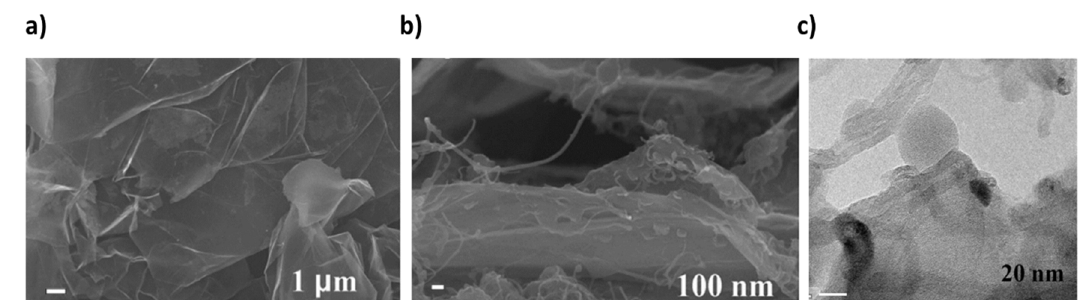
Figure 13. ( a ) SEM image of exfoliated graphene and the graphene/MWCNT/PS nanocomposites